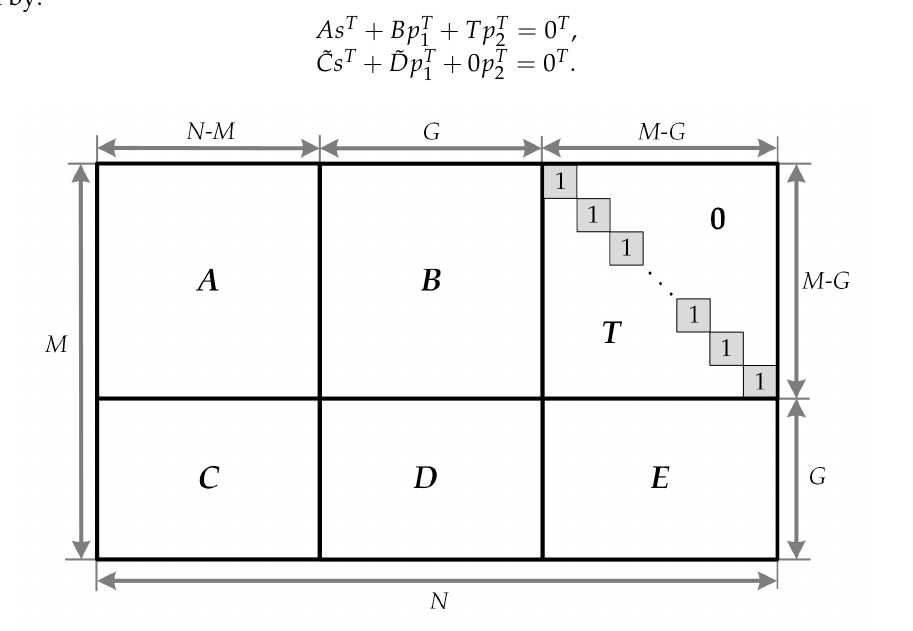
Figure 3. The parity check matrix H in approximate lower triangular